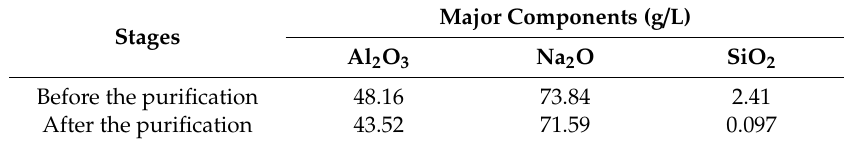
Table 2. The mass concentrations of major components of NaAlO 2 solution before and after the purification.